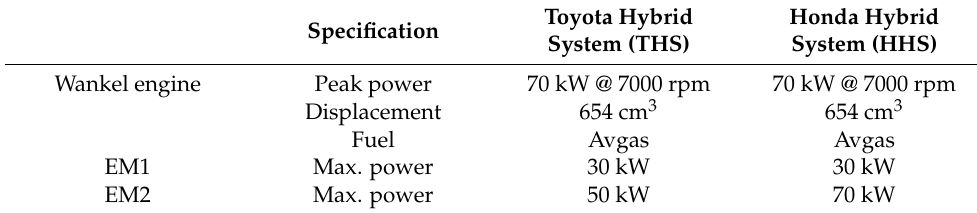
Table 4. Specifications of the old and new